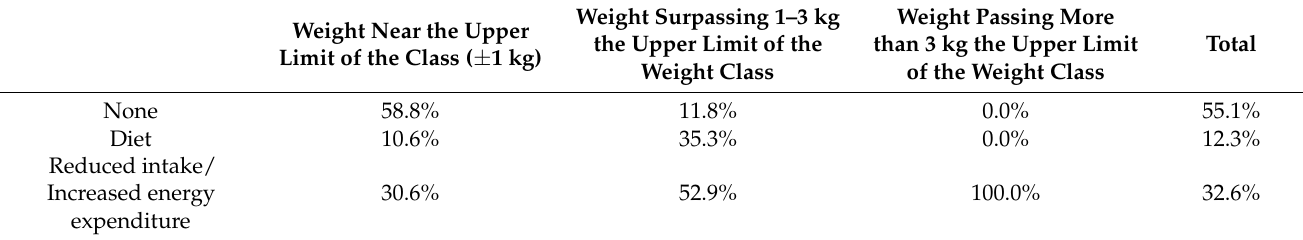
Table 4. Strategies to lose weight vs. difference of weight respect to weight